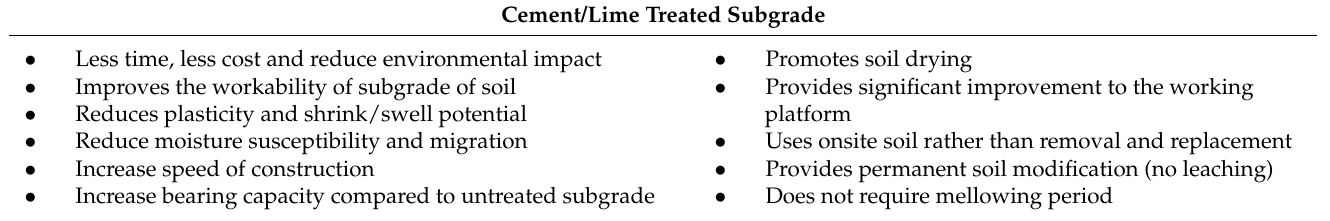
Table 1. Merits of in situ stabilised subgrade and demerits of subgrade removal and replacement